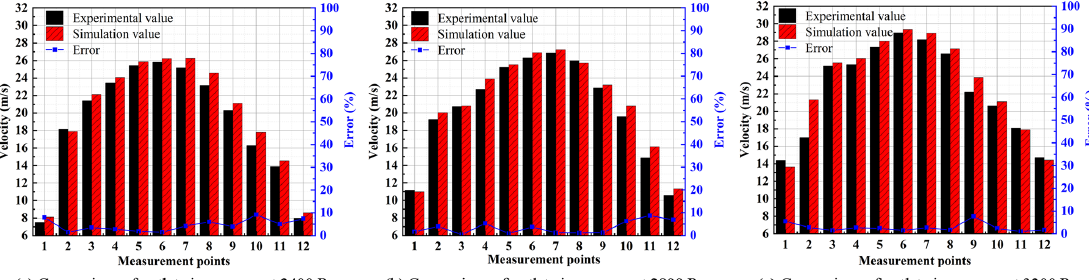
Figure 10. Simulation and test comparison of inlet air velocity at different negative pressures.